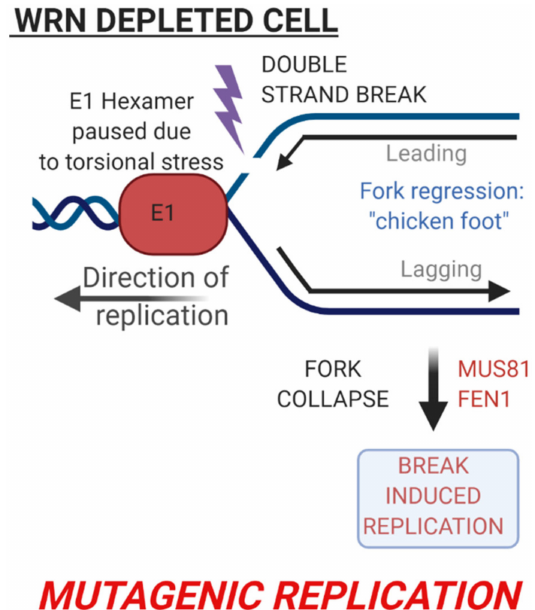
Figure3. MutagenicreplicationintheabsenceofWRNispotentiallydrivenbybreak-inducedreplication. WRN depletion results in excess recruitment of MUS81 to E1–E2-replicating DNA. The endonuclease function of MUS81 cleaves the stalled fork, resulting in break-induced replication of the DNA, a mutagenic